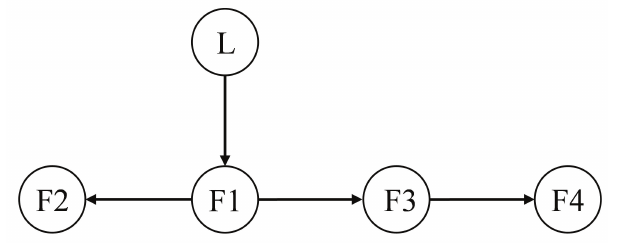
Figure 2. The communication topology for non-triangular